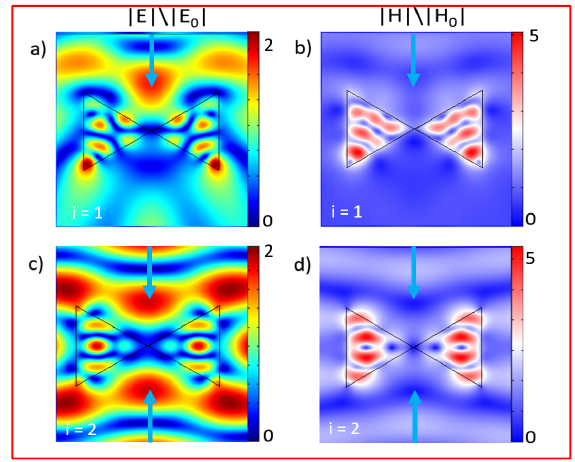
Figure A1. The electric ( a ), ( c ) and magnetic ( b ), ( d ) field enhancement in the case of one plane wave propagating along the y -axis [( a ), ( b )] or two counter propagating y -axis excitations [( c ), ( d )].